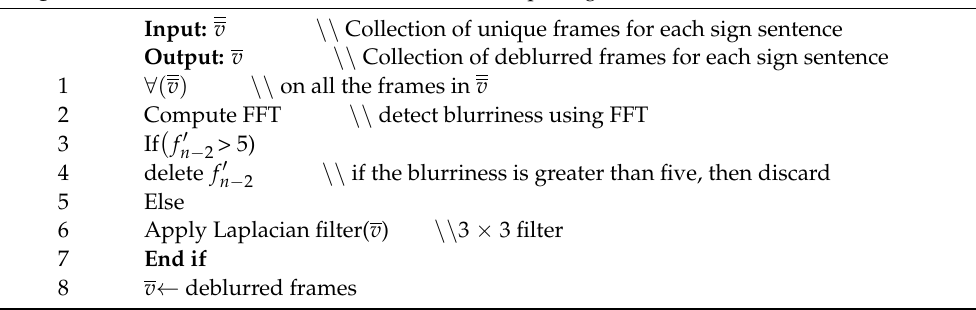
Algorithm 2: Removal Of Blurred Frames And Sharpening